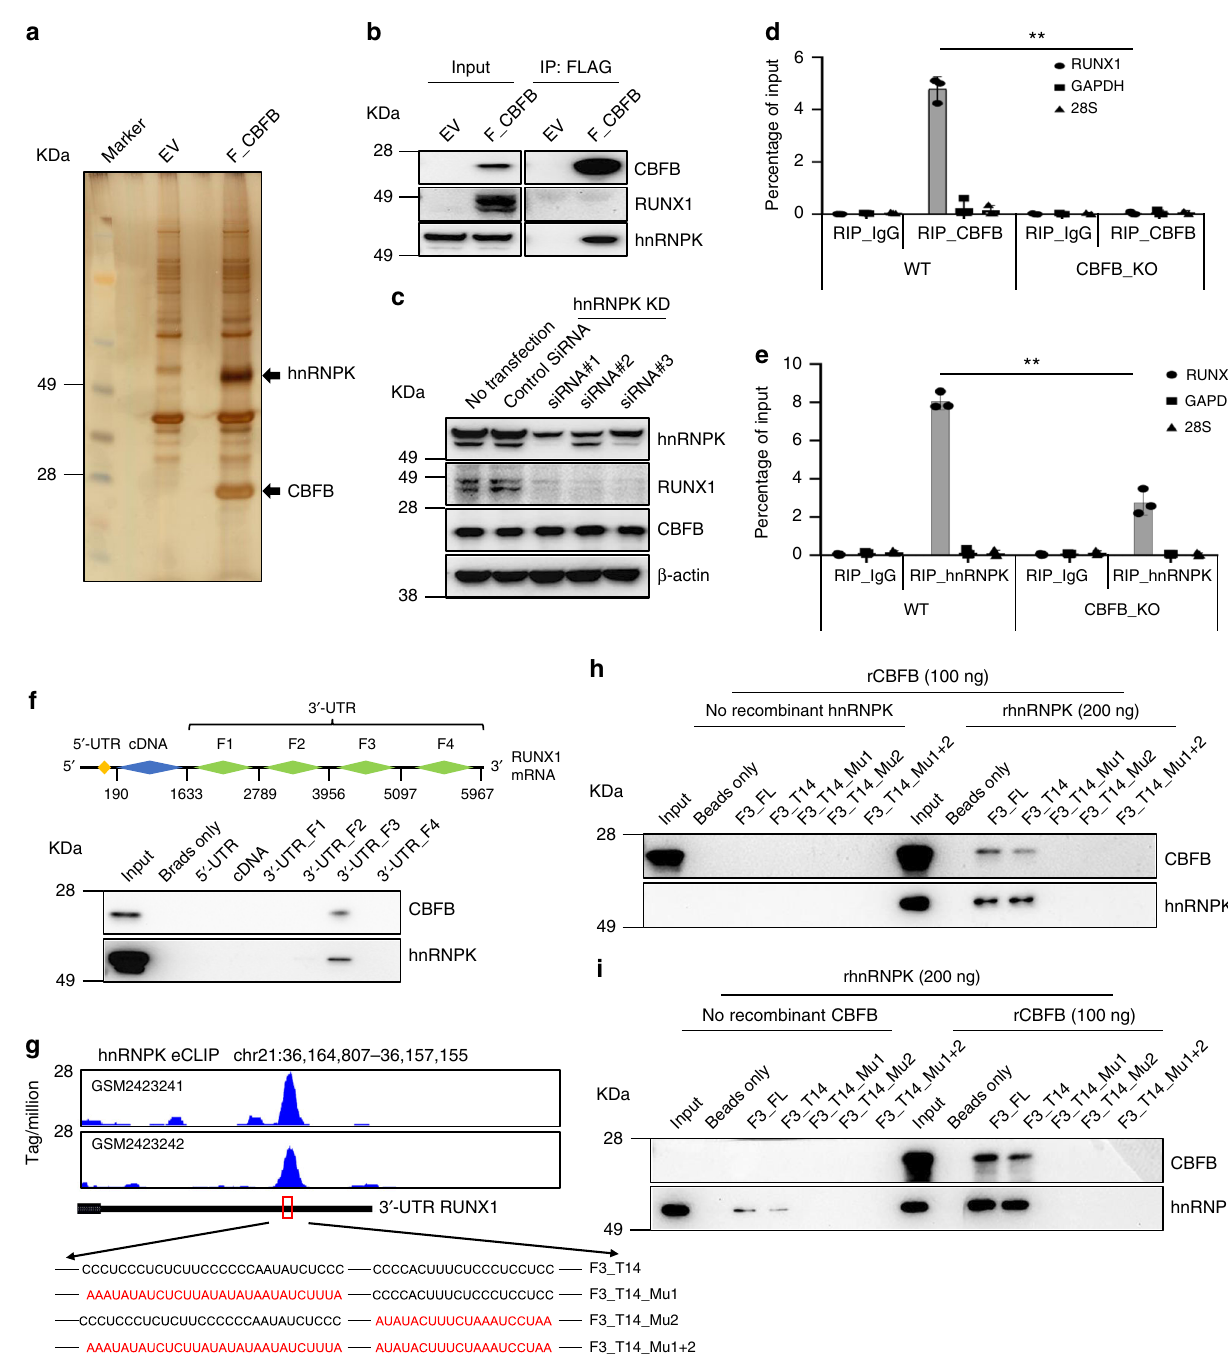
Fig. 2 CBFB binds to RUNX1 mRNA via hnRNPK. a Silver staining of FLAG pulldown using CBFB KO MCF10A cells expressing empty vector and N-terminally FLAG tagged CBFB. b IB validation of CBFB and hnRNPK interaction. c IB showing the effect of hnRNPK knockdown on RUNX1 protein. d RNA immunoprecipitation (RIP) with CBFB antibody in WT and CBFB_KO MCF10A cells. Error bars are SEM, n = 3 (biological); two asterisks, p value < 0.01. (RIP of CBFB in WT vs. in CBFB KO cells, two-tailed t test). e RIP with hnRNPK antibody. Error bars are SEM, n = 3 (biological); two asterisks, p value < 0.01 (RIP of hnRNPK in WT vs. CBFB KO cells, two-tailed t test). f RNA pulldown assays (RPA) determining the hnRNPK-bound region within RUNX1 mRNA. F1- 4, fragment 1 to 4 of 3 ′ UTR of RUNX1 mRNA. See Methods for details. Numbers indicate the nucleotide positions. g Re-analyses of two public eCLIP datasets (GSM2423241 and GSM2423242) of hnRNPK on the RUNX1 locus. Nucleotide sequences of two poly-C tracts within the binding site of hnRNPK were shown. F3, fragment 3 of 3 ′ -UTR; T14, truncation 14 of 3 ′ -UTR F3; Mu1, mutation 1; Mu2, mutation 2. h RPA using recombinant CBFB in the absence